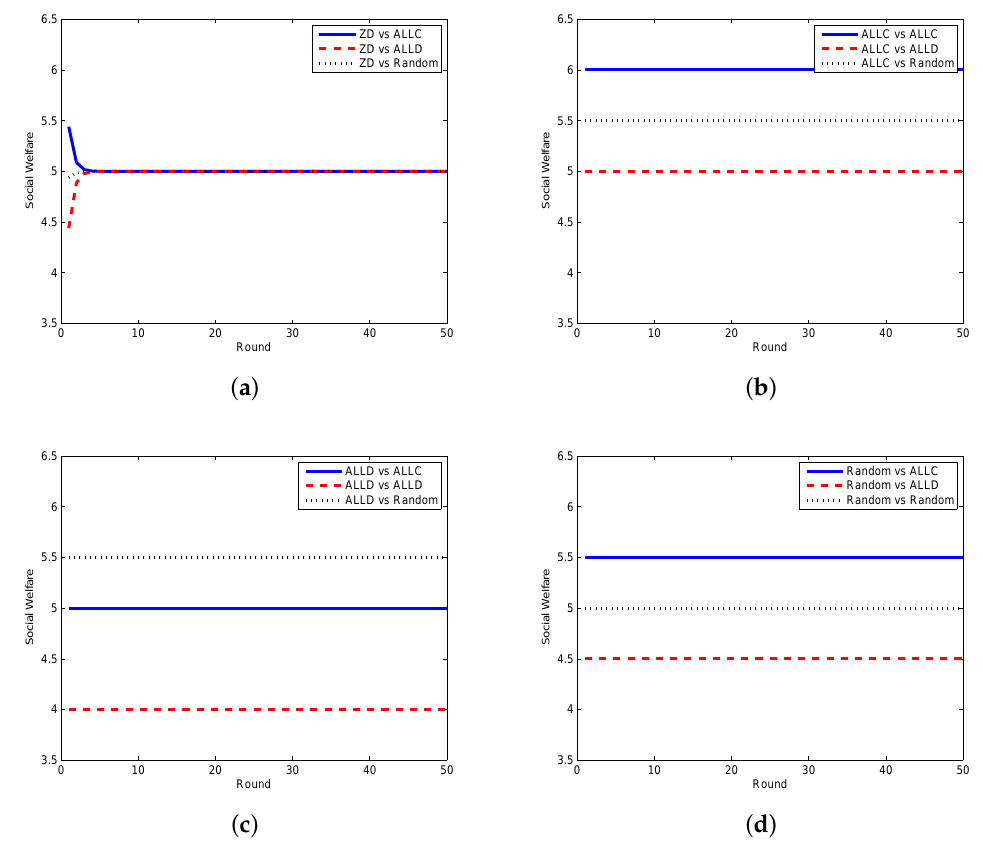
Figure 2. Social welfare with different strategy pairs (requestor vs. worker) among ZD, ALLC, ALLD, and Random in the discrete model. ( a ) requestor adopts the ZD strategy; ( b ) requestor adopts the ALLC strategy; ( c ) requestor adopts the ALLD strategy; ( d ) requestor adopts the Random strategy.